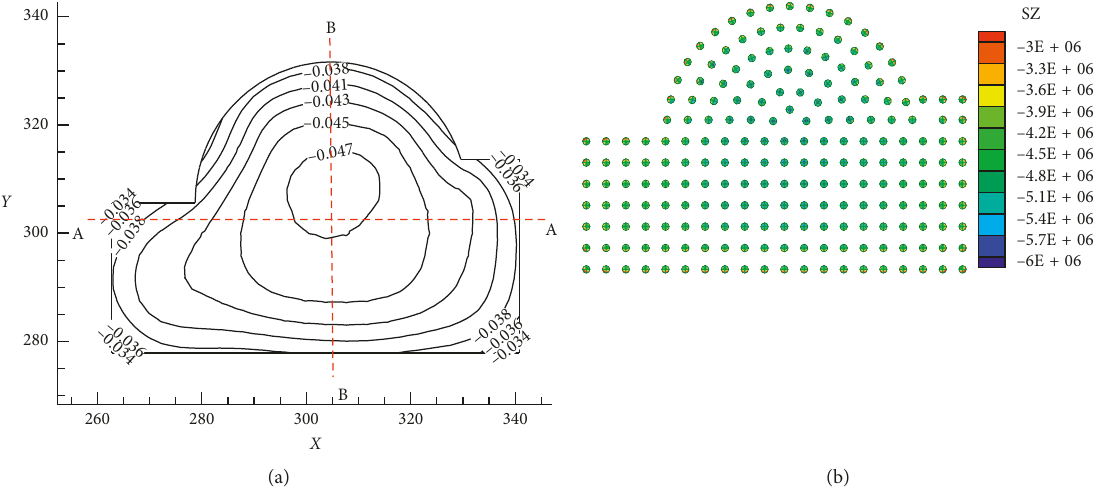
Figure 7: The result of the initial design: (a) initial settlement on top of the piled raft (m); (b) vertical stress on top of the pile groups